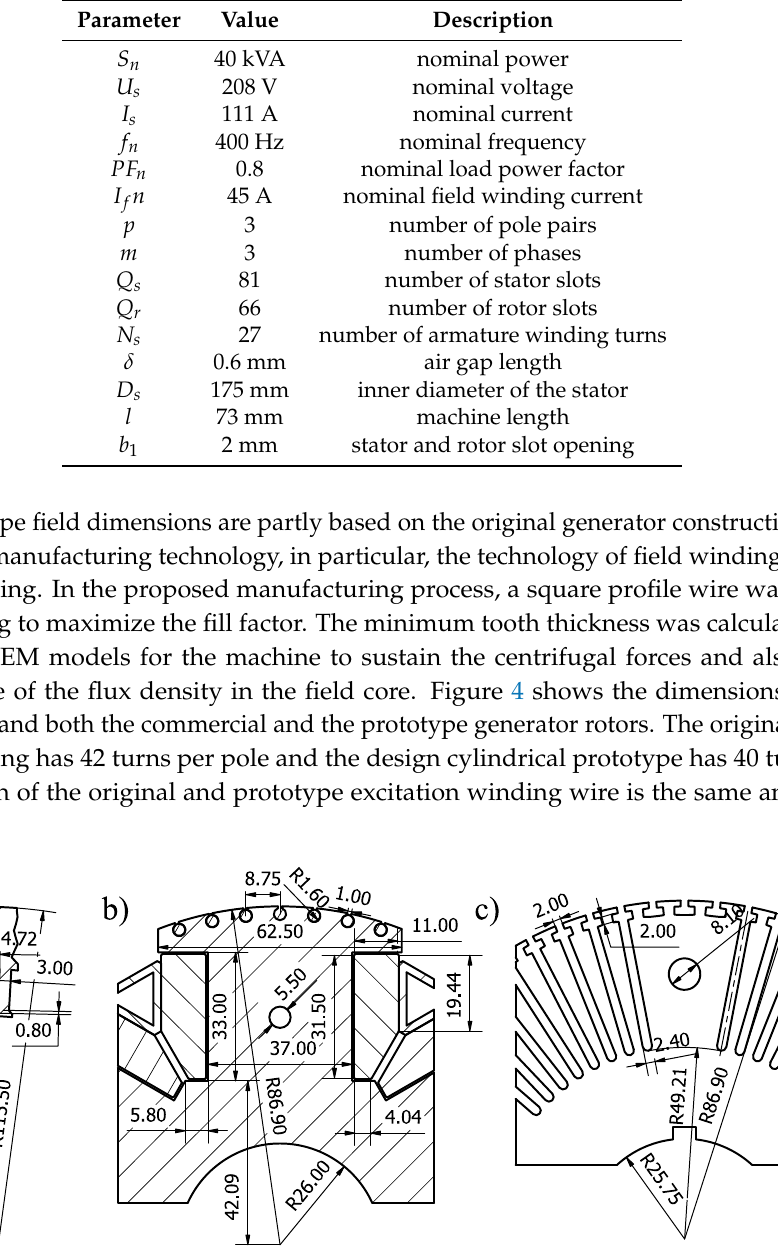
Figure 4. Dimensions of the: ( a ) main generator stator; ( b ) original salient pole rotor; ( c ) prototype non-salient pole